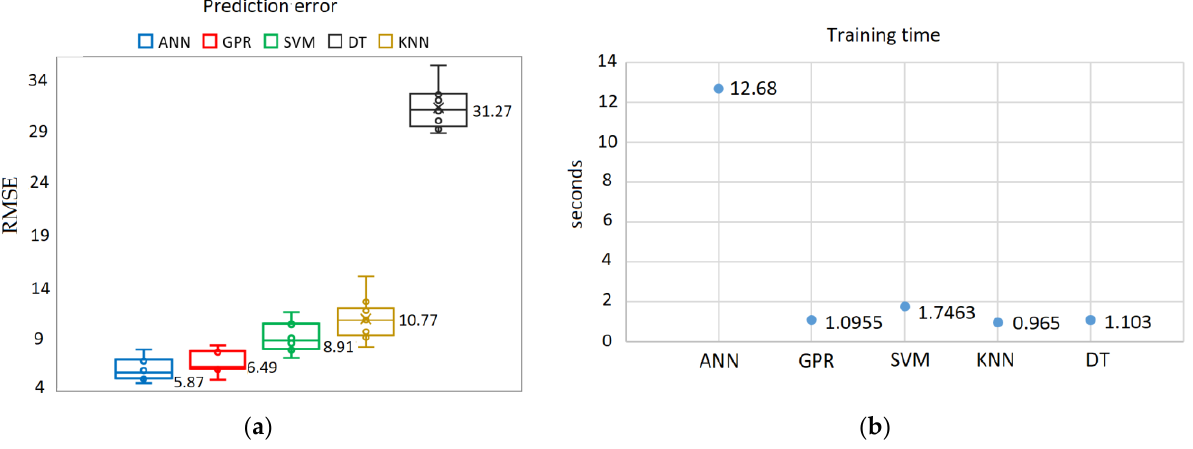
Figure 7. Prediction results using different machine learning algorithms: ANN, GPR, SVM, KNN, DT: ( a ) prediction error suing k-folds cross-validation, where k = 10; ( b ) training time results.